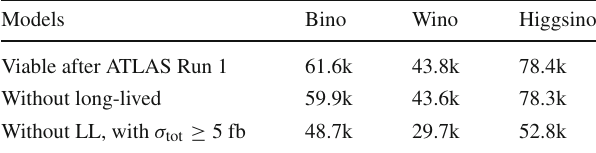
Table 3 Viable model points before Run 2 constraints. These are clas- sified by the dominant contribution to the LSP being bino, wino or Hig- gsino. Long-lived (LL) gluinos, squarks and sleptons with c τ > 1 mm require dedicated Monte-Carlo simulation and are omitted from this study. Event simulation was performed on non-LL models with